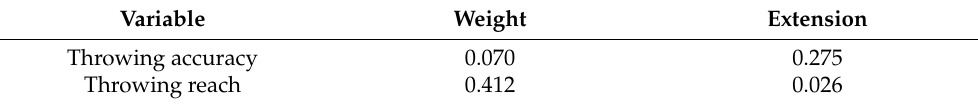
Table 3. Summary of p -values for one-tailed paired t